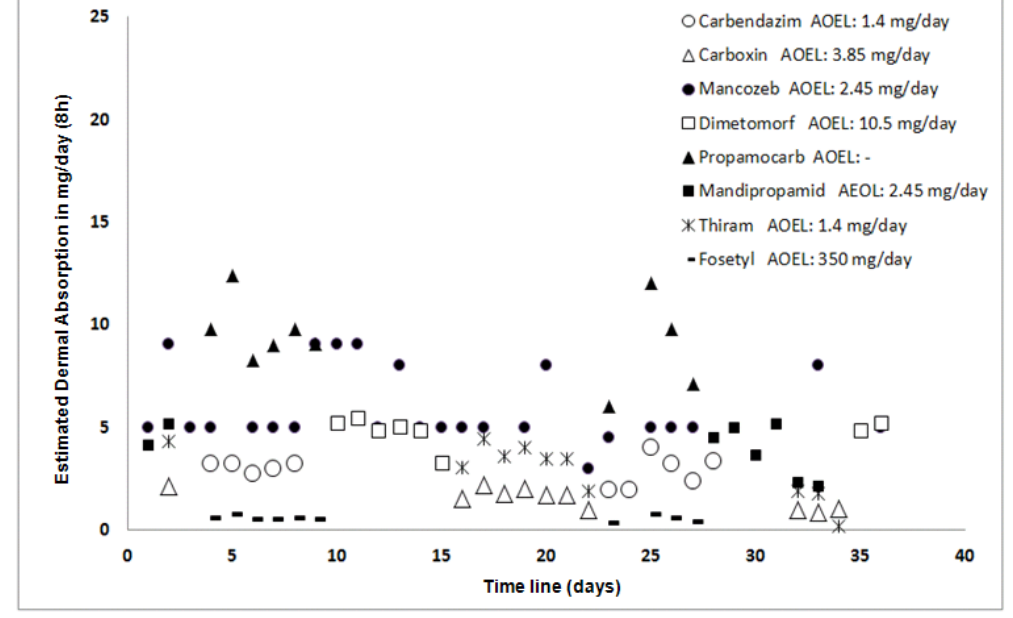
Figure 5. Estimated daily dermal absorption of pesticides for the evaluated pesticide management period of six weeks. Estimations are based on the actual dermal exposures (arithmetic mean, n = 9) calculated with the pesticide flow model and the absorption reference values for each pesticide reported in the AERU Pesticide Properties Database